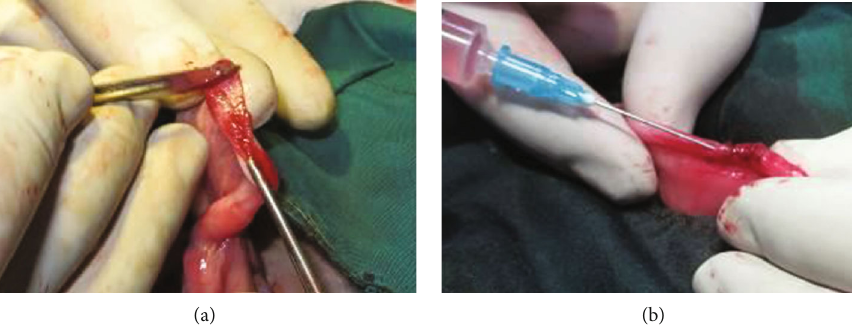
Figure 1: Surgical procedure of the evaluation of preventive e ff ects of intrauterine stromal cell-conditioned media injection on uterine fi brosis after endometrial curettage in rabbits. (a) Intrauterine curettage of the rabbit uterus using a scalpel blade. (b) Injection of mesenchymal stromal cells or stromal cell-conditioned media after suturing of curettage uterus in treatment groups.